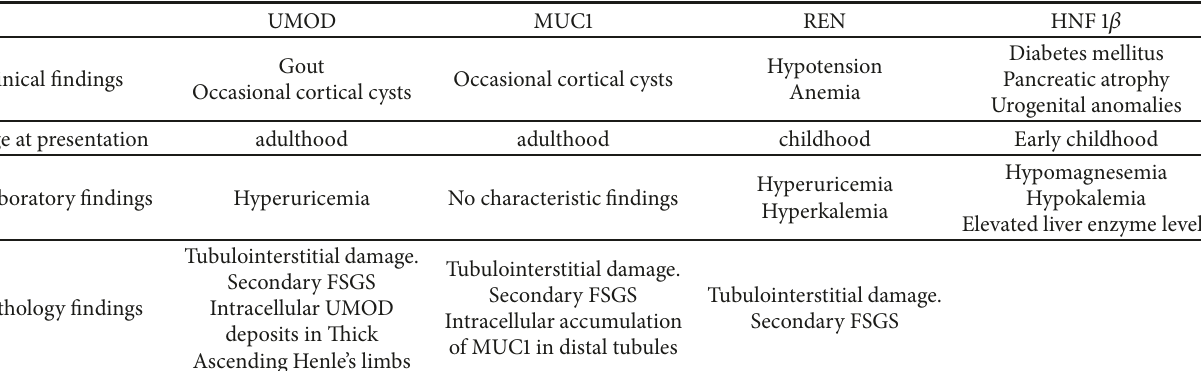
Table 1: Main findings of the different genetic subtypes of